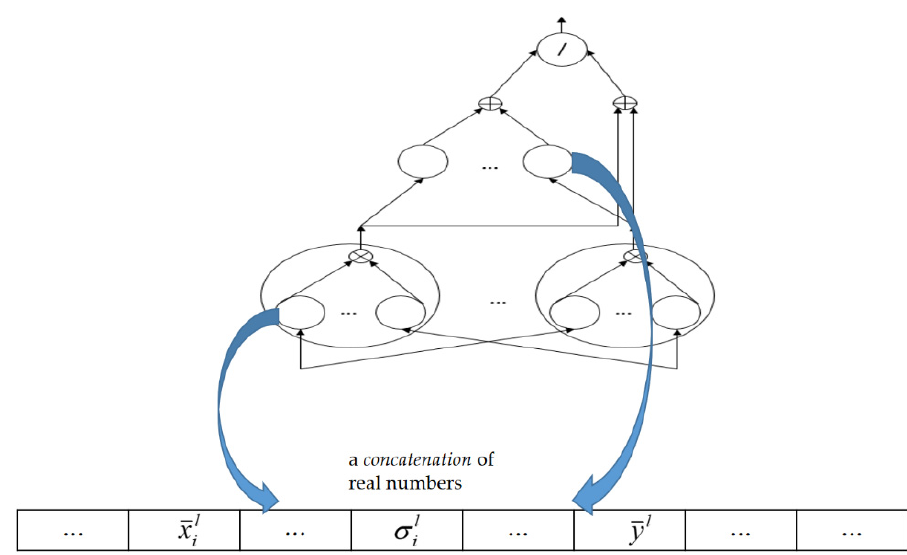
Figure 3. Illustration of the chromosomal design encoding the connectionism into a chromosome—a real-number string.